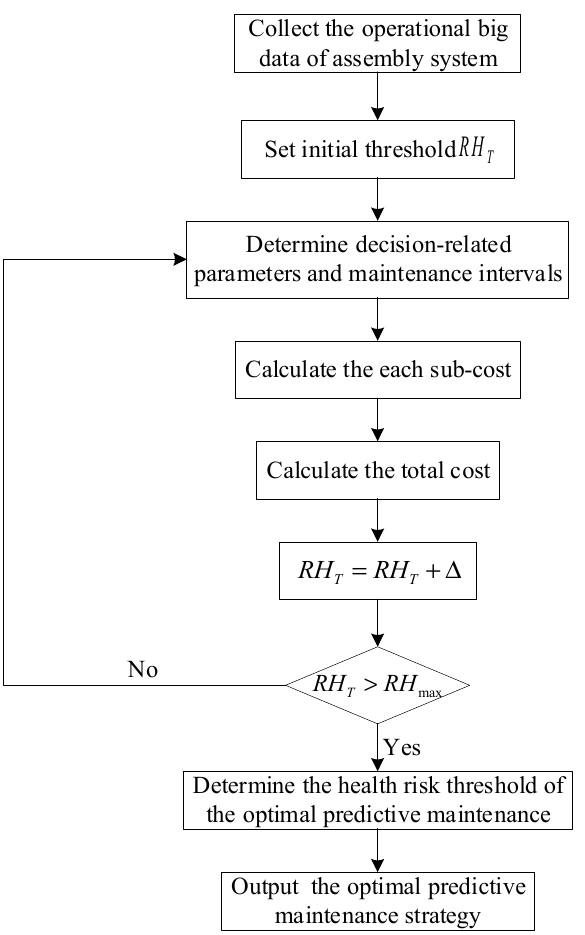
Figure 6. Diagram of health risk-oriented predictive maintenance decision-making mechanism.